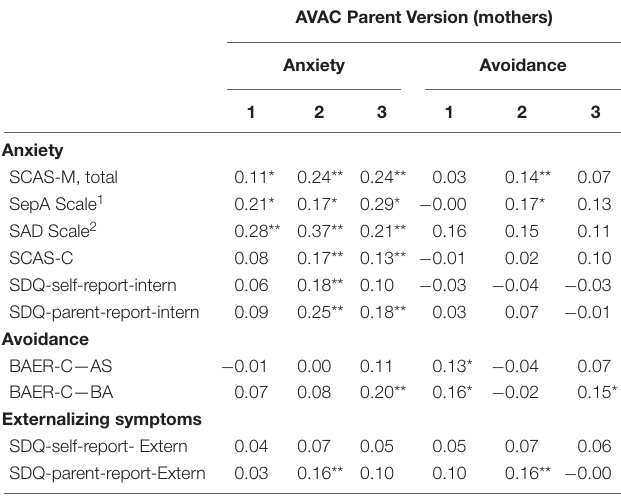
TABLE 3 | Correlations between the AVAC parent version and measures of anxiety symptoms and avoidance (convergent validity), as well as externalizing symptoms (divergent validity).